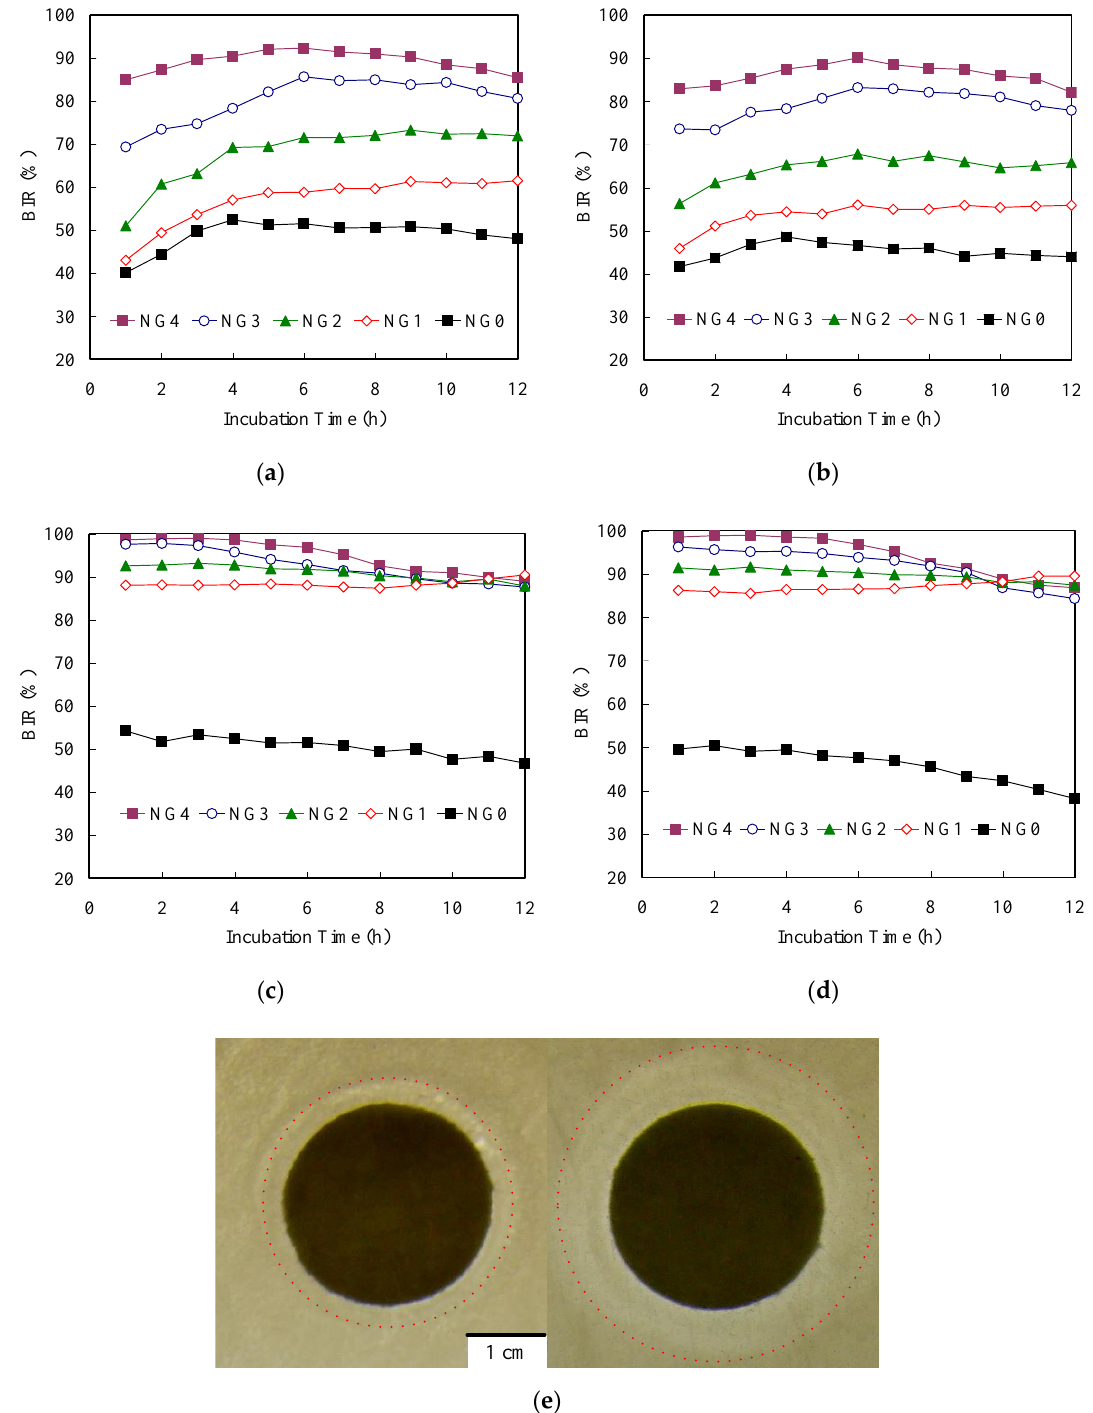
Figure 9. Bacteria inhibition ratios (BIRs) of AMX-loaded NG0, NG1, NG2, NG3, and NG4 against ( a ) E. coli and ( b ) S. aureus at 25 °C, and ( c ) E. coli and ( d ) S. aureus at 37 °C plotted as a function of incubation time. ( e ) Zone inhibitions of NG1 against S. aureus for 6 h at 25 ( left ) and 37 °C ( right ), respectively. Data are mean ± SD, n = 3, Student’s t test, p < 0.05.